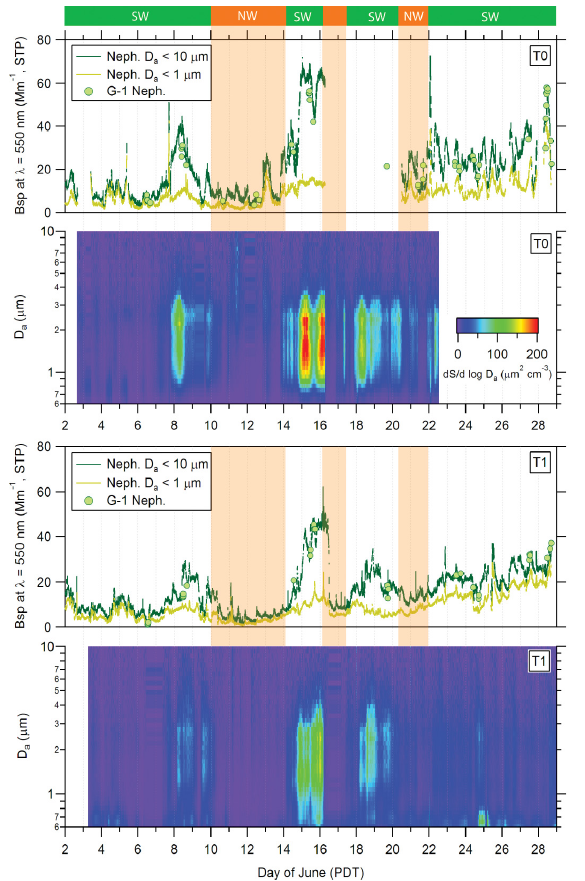
Fig. 18. Comparison of scattering coefficient measured by neph- elometer at the T0 and T1 sites and onboard the G-1 during over- passes at the respective sites.